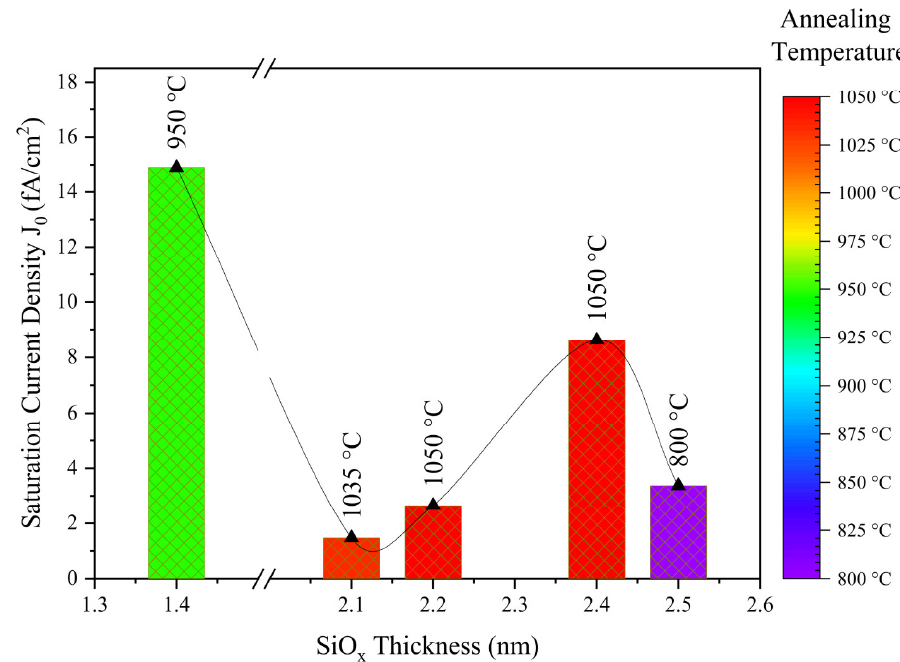
Figure 10. Saturation current density versus thickness of thermally produced SiO x layer at various temperatures of annealing [71,94].